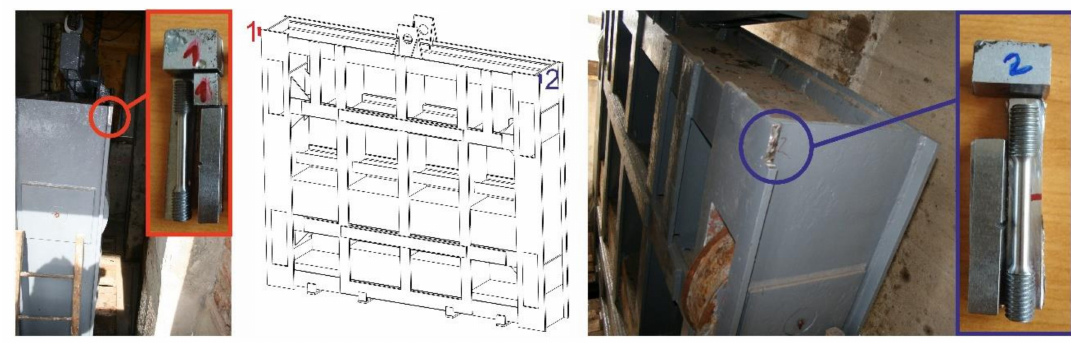
Figure 3. Locations of material samples.